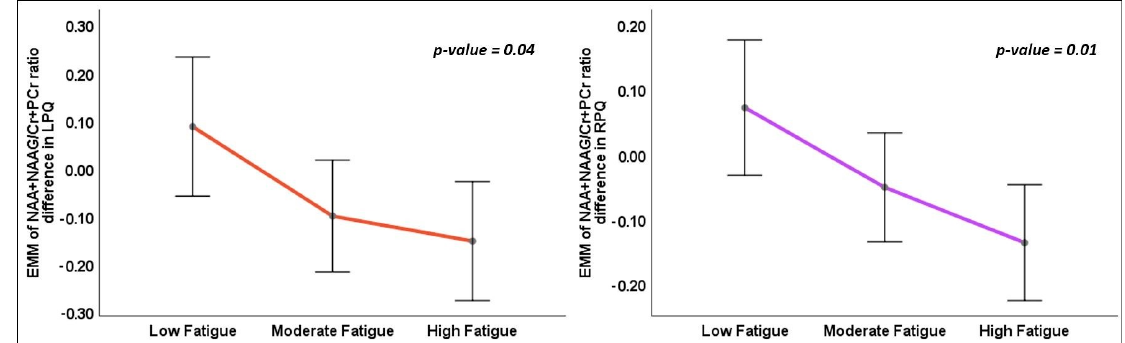
Figure 5. Line graphs representing the estimated marginal mean and standard error of mean (SEM) of the NAA+NAAG/Cr+PCr ratio difference (year 1 minus baseline) in the left posterior quadrant (LPQ) and right posterior quadrant (RPQ) between the fatigue groups at baseline and year 1. The p-value represents the statistical significance of the main effect of fatigue groups in the one-way ANOVA.